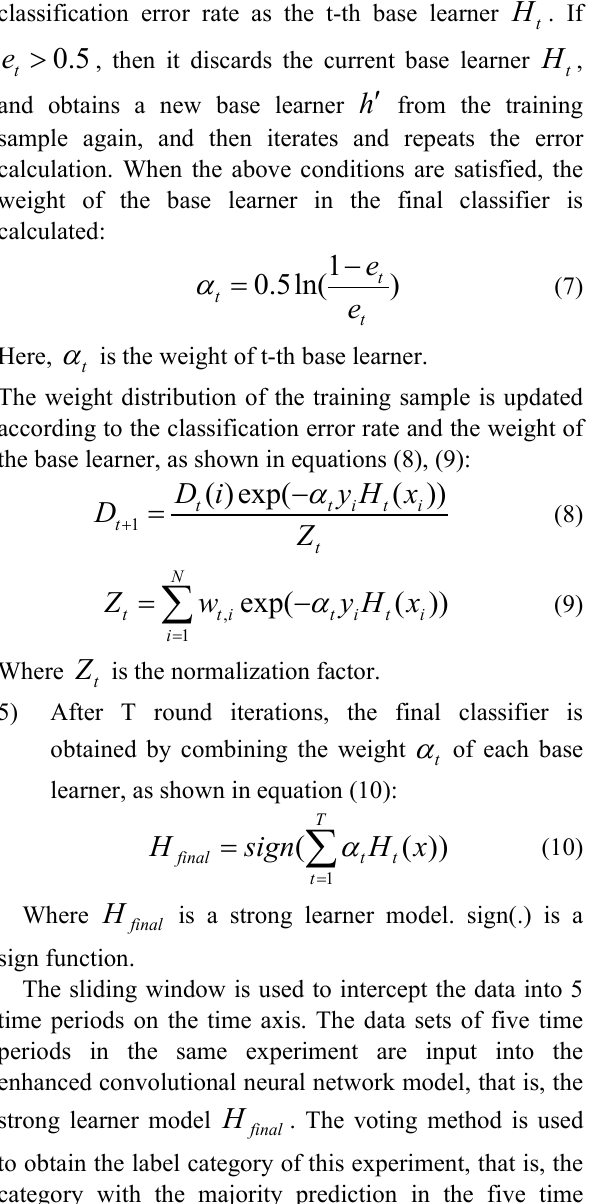
Table 1. Comparison of classification accuracy